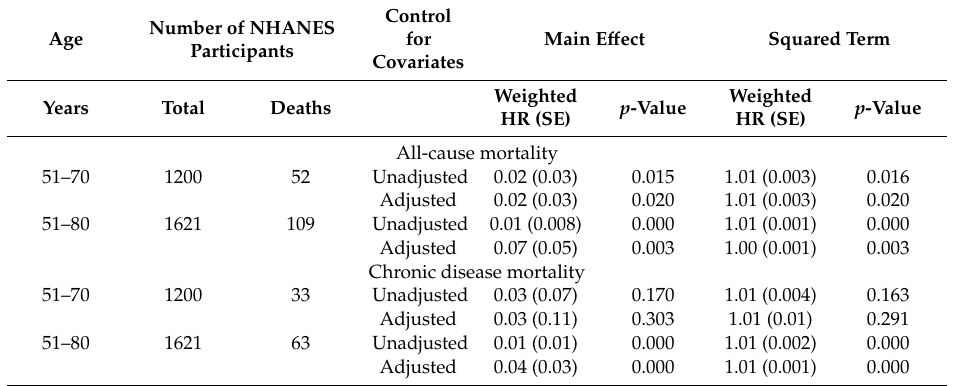
Table A1. Sensitivity analysis checking for a U-shaped relationship between serum osmolality and all-cause and chronic disease mortality in NHANES 2009–2012 participants aged 51–80 years.